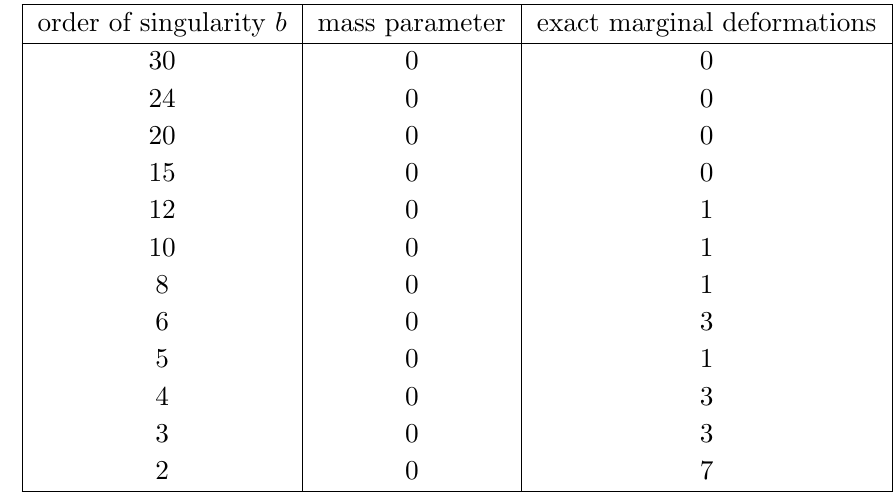
Table 6 . Summary of mass parameters and number of exact marginal deformations in E 8 . Argyres-Douglas